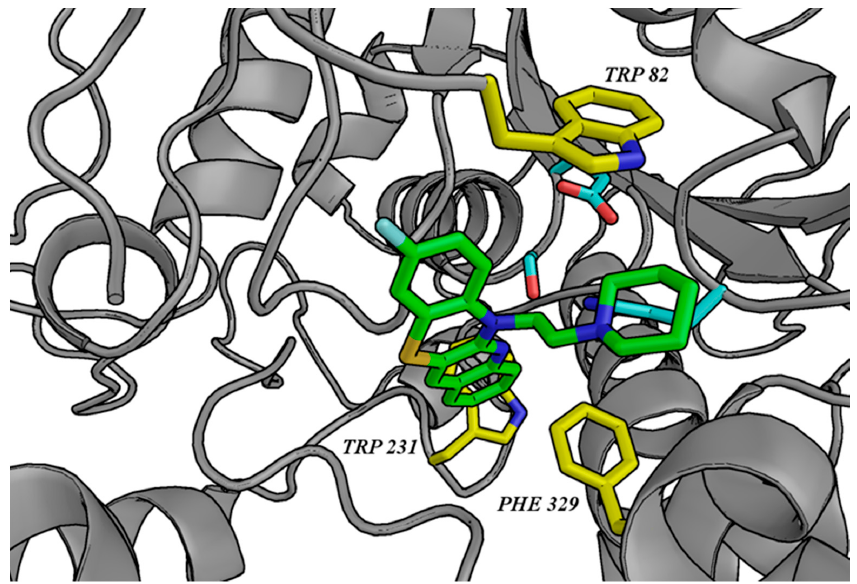
Figure 7. Binding mode of compound 23 in the active site of butyrylcholinesterase.